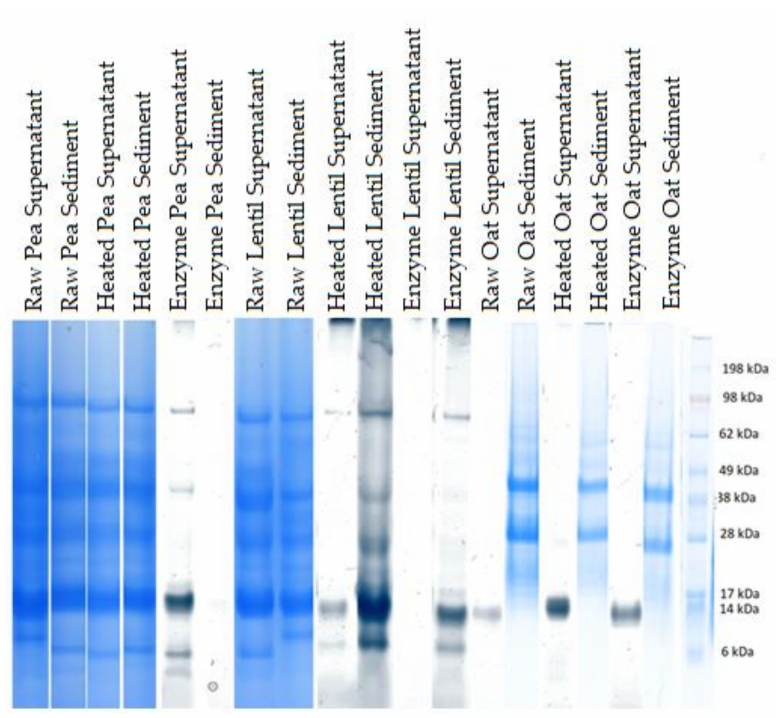
Figure 1. Major protein sizes as determined by SDS-PAGE for the single-ingredient samples, analyzed under reducing condition. Furthest left lane: MW ladder.